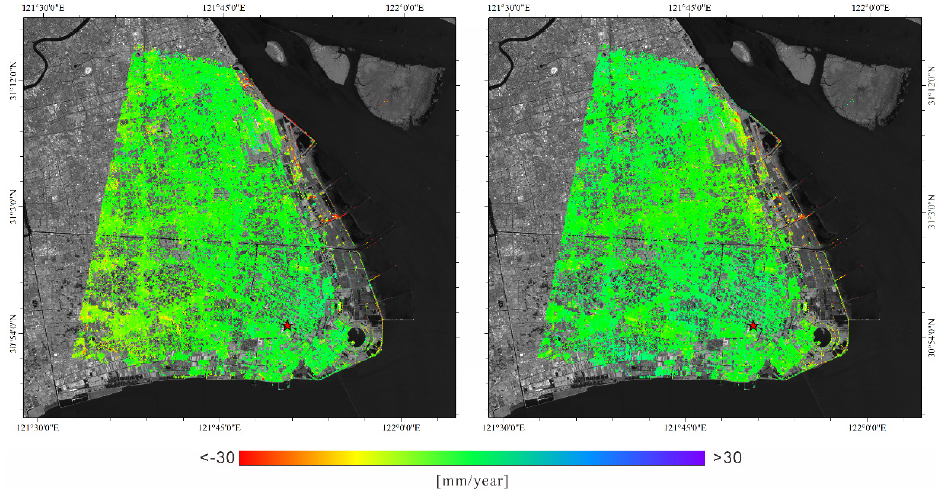
Figure 1. LOS-projected mean displacement velocity map retrieved by processing the CSK dataset ( left ) and the S1-A dataset ( right ) in an overlapping period between 26 February 2015 and 4 March 2016. Only coherent SAR pixels common to both CSK and S1-A datasets are displayed. The red star identifies the location of the reference pixel, which is assumed to be stable (refer to [26]).